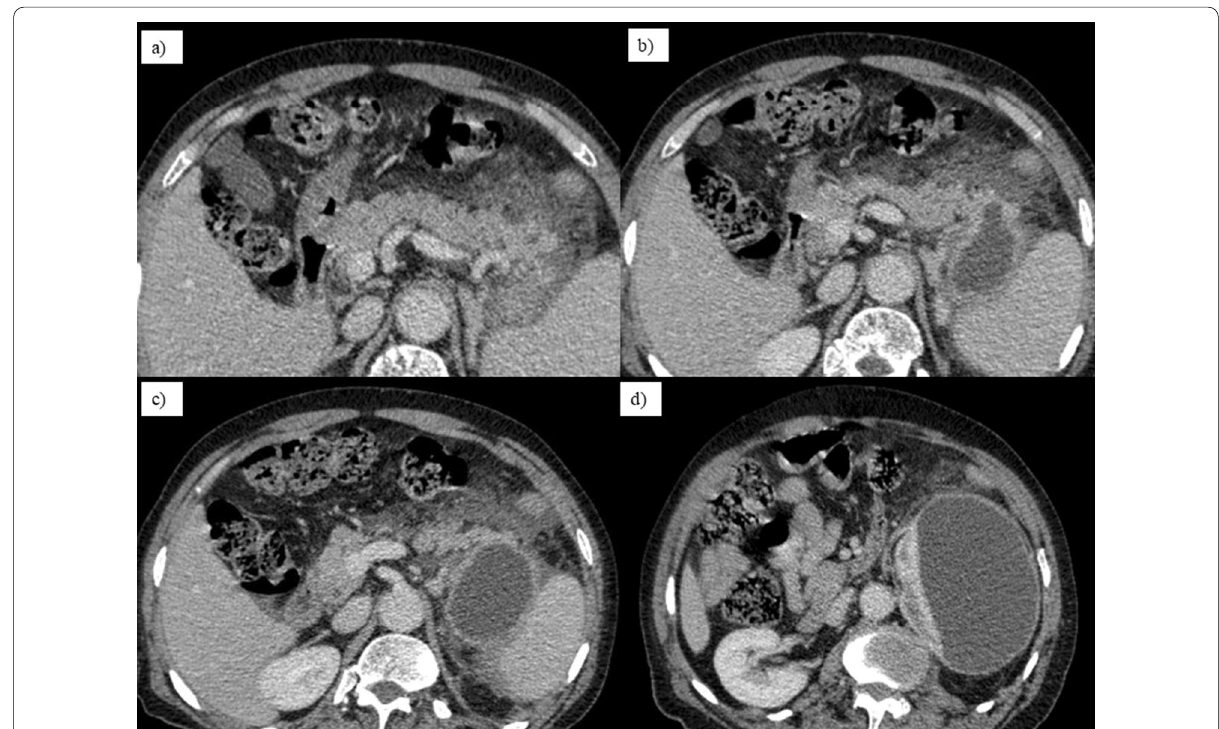
Fig. 1 Axial CECT abdomen images a – d showing peripherally enhancing cystic collection extending from pancreatic tail into the subcapsular plane of left kidney causing its compression. Peripancreatic inflammatory changes are also